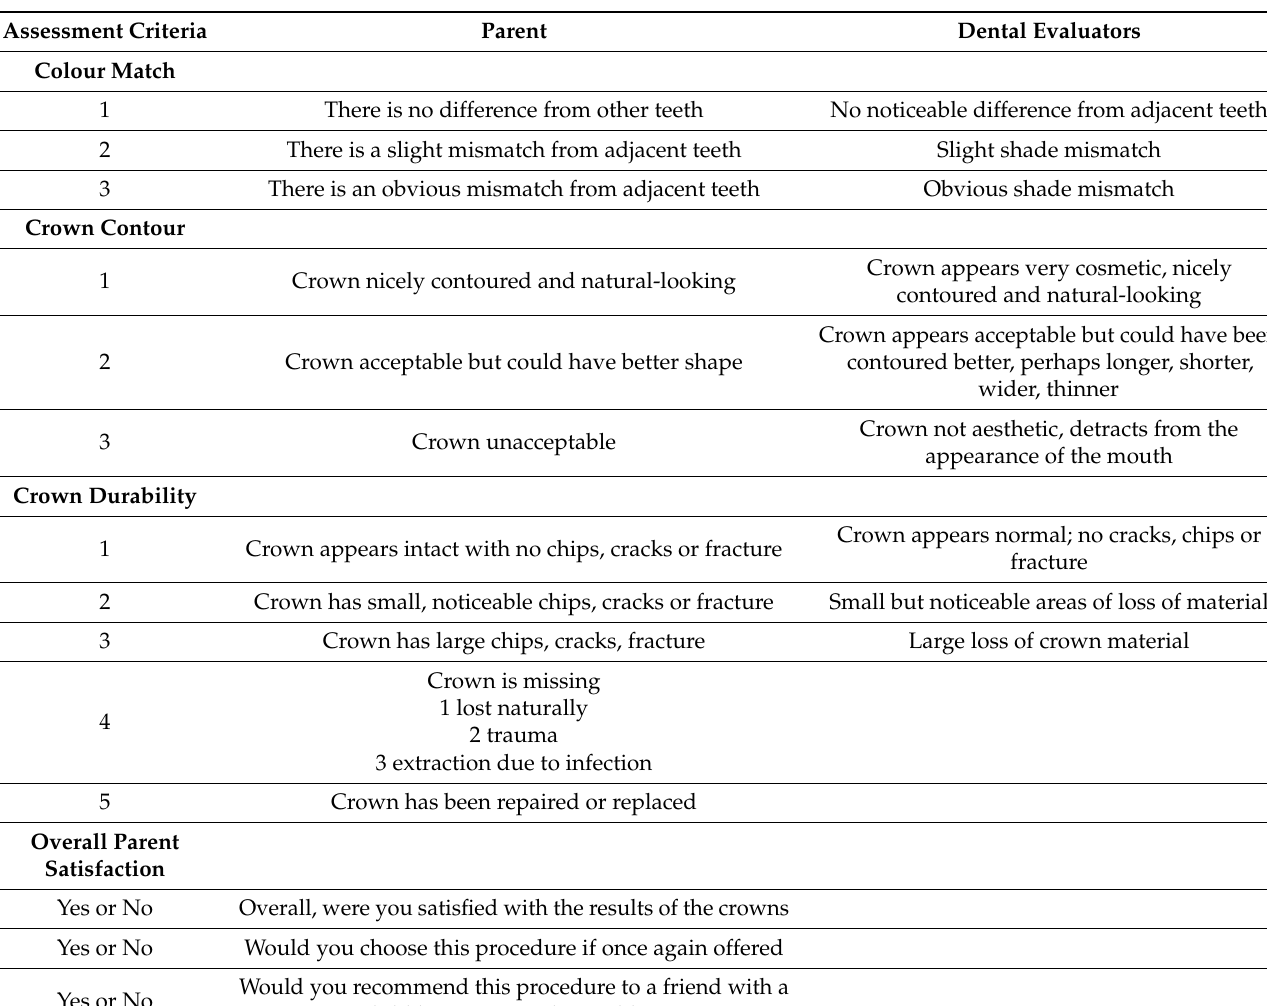
Table 1. Assessment criteria for parents and dental